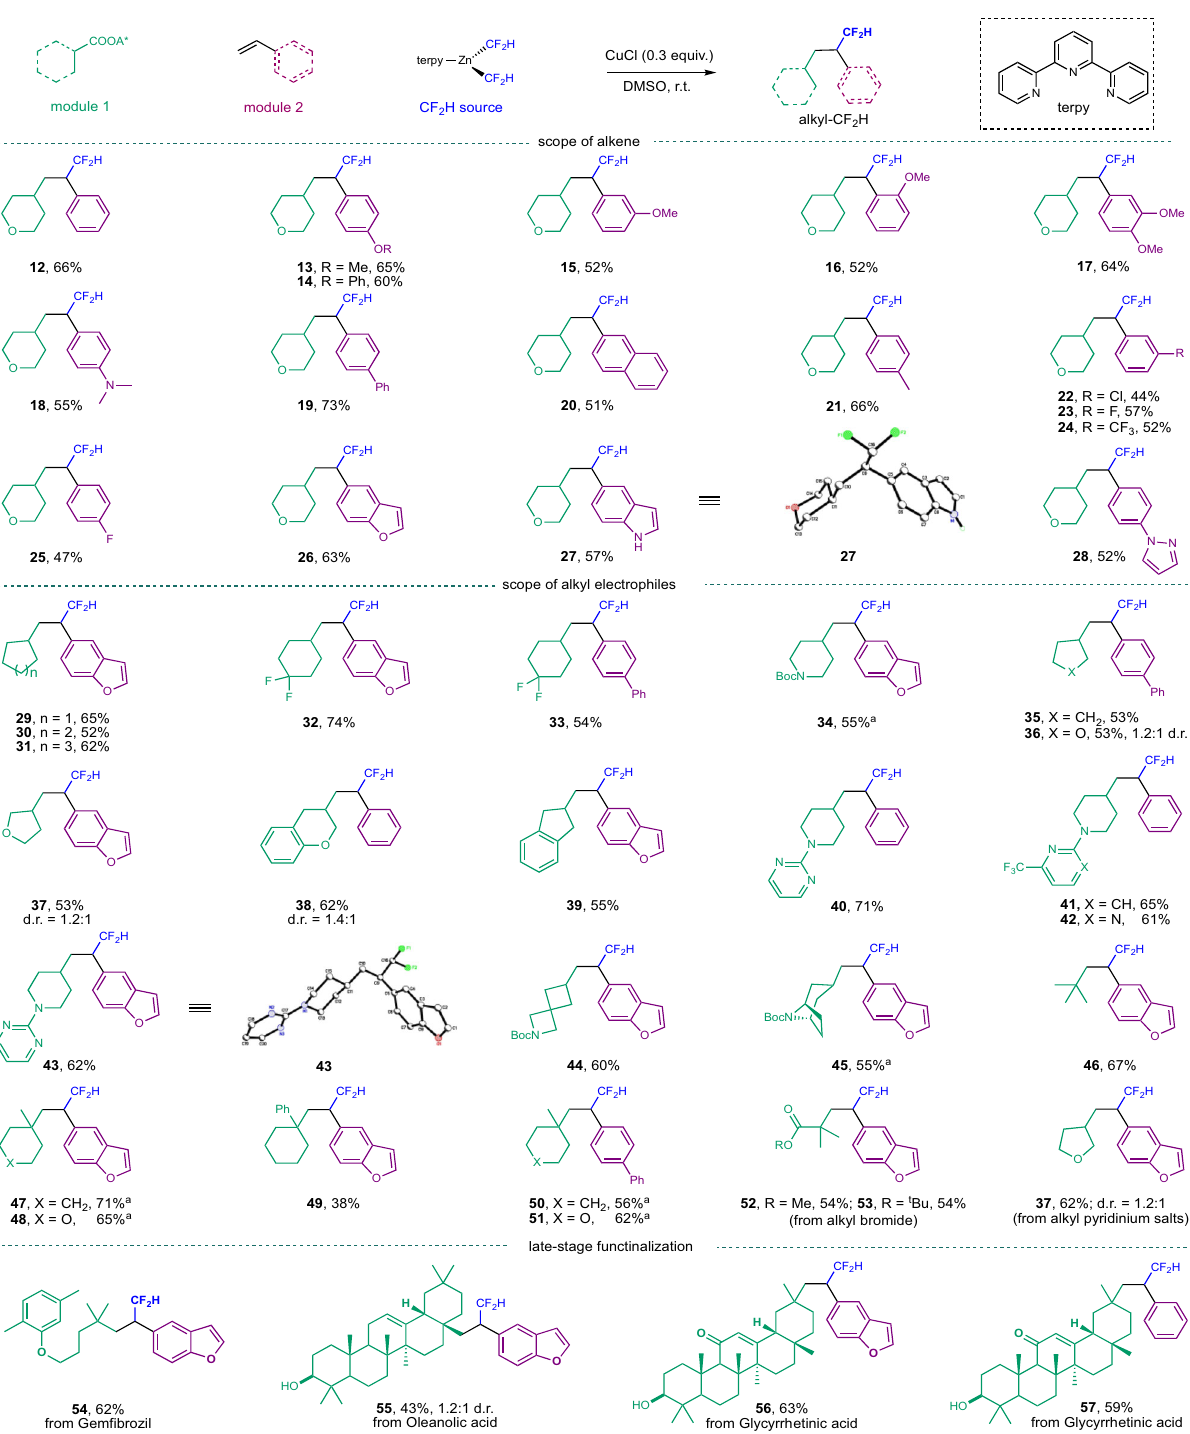
Fig. 4 Copper-catalyzed di fl uoromethyl-alkylation of alkenes. Reactions were run with 0.25 mmol of RAEs, 0.75 mmol of alkenes (3.0 equiv.), 0.2 mmol of (terpy)Zn(CF 2 H) 2 (0.8 equiv.), and CuCl (30 mol%) in 1 mL of DMSO at r.t., isolated yields based on RAEs. a Reaction performed under modi fi ed conditions (Supplementary Method 5). terpy, 2,2 ʹ ;6 ʹ ,2 ʺ -terpyridine; DMSO, dimethyl recovered with excellent mass balance (Supplementary with an aryl chloride ( 22 ) provides the basis for the further Method 1). synthetic manipulation of the di fl uoromethylated products. This protocol allowed for the ef fi cient installation of nitrogen- and oxygen-containing heterocycles, including benzofuran ( 26 ), ubiquitous in pharmaceuticals, into alkyl-CF 2 H moieties in good yields. It is worth noting that the excess vinyl arenes could be